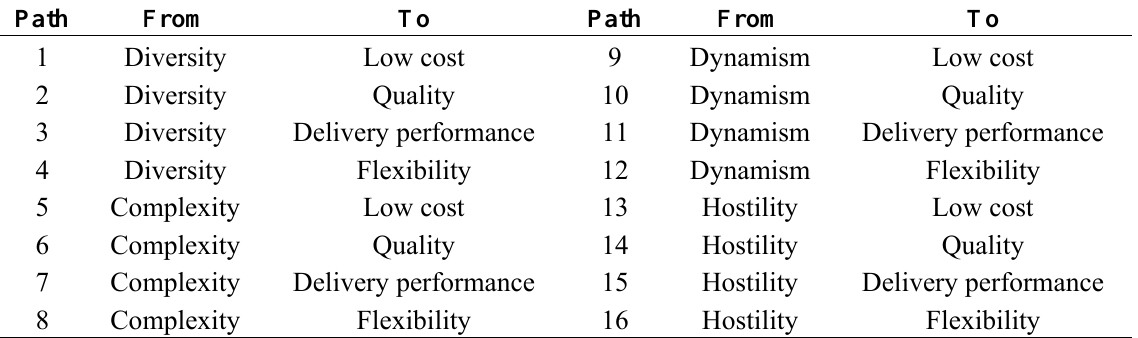
Table 1. Tested relationships between environmental dimensions and strategy